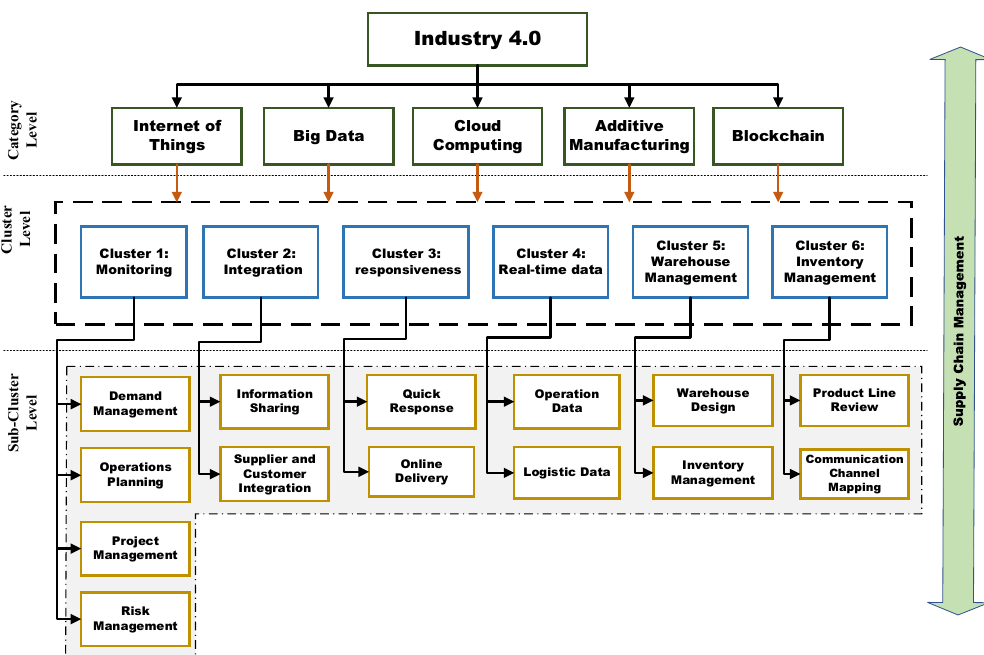
Figure 13. Identification of category, clusters, and